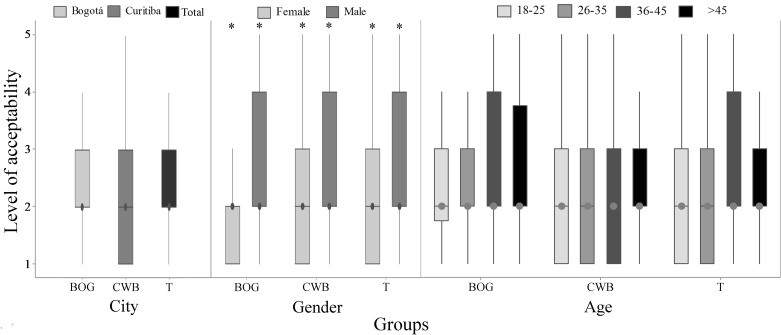
Acceptability of catch-and-release angling (Q4) by 782 citizens of Bogotá and Curitiba, 2014/2015.Data for city, gender and age; 1 = certainly not and 5 = certainly yes; (BOG) represents data from Bogotá, (CWB) data from Curitiba and (T) the total data; the asterisk indicates gender difference (P<0.05, Mann-Whitney).